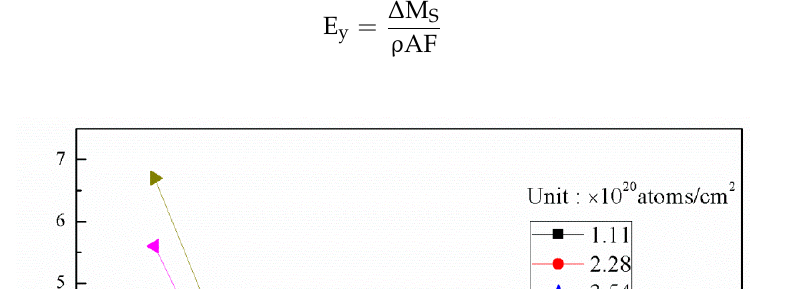
Figure 7. Mass loss of coated Kapton with different graphene loadings in the AO exposure experiment.